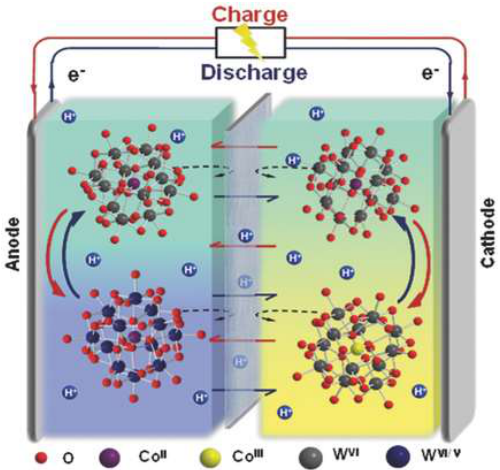
Figure 5. The working principle of the all-H 6 [CoW 12 O 40 ] RFB, the structure of [CoW 12 O 40 ] n- (ball-and-stick notation) [135]. Copyright 2017, John Wiley and Sons.